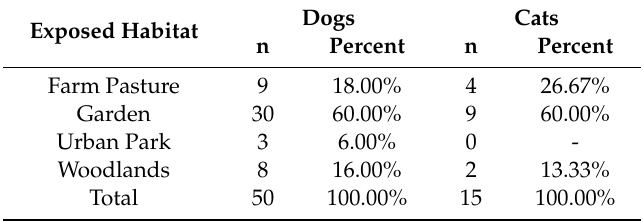
Table 2. Habitat exposure of dogs and cats in the two weeks prior to tick